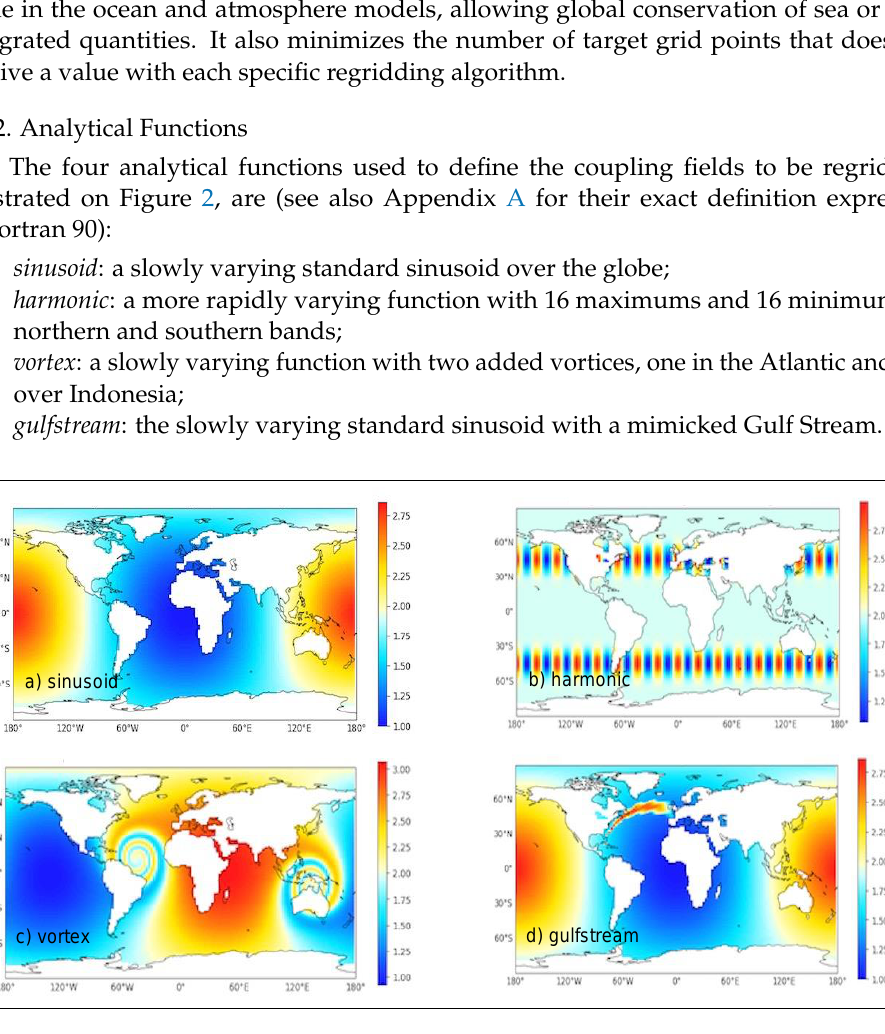
Figure 2. The four analytical functions defining the coupling field: ( a ) sinusoid , ( b ) harmonic , ( c ) vortex , ( d ) gulfstream .